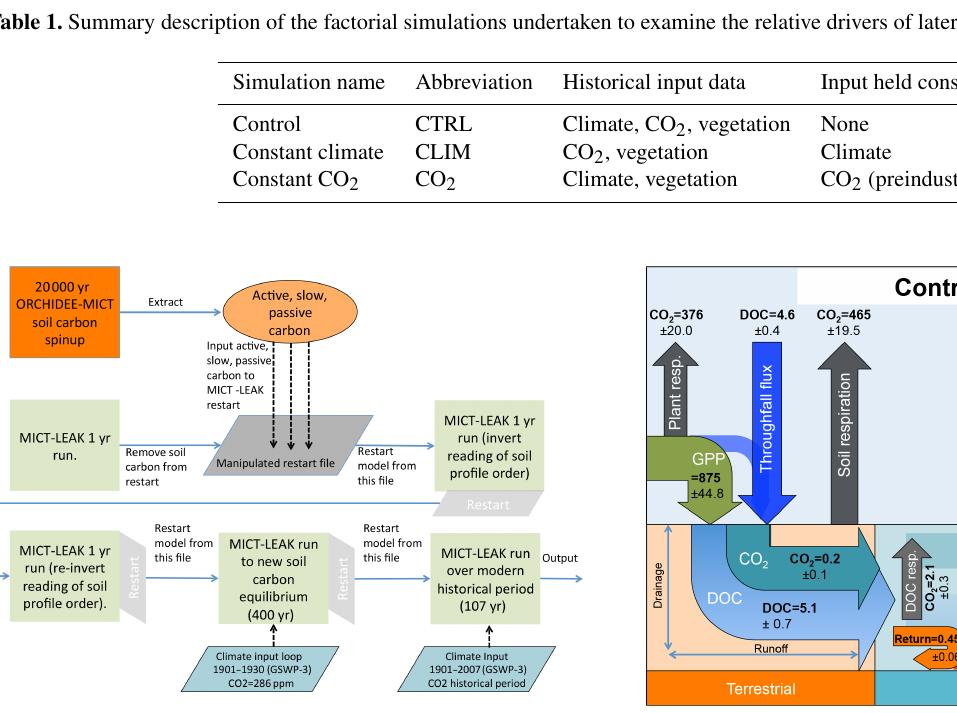
Figure 2. Schematic diagrams detailing the major yearly carbon flux outputs (TgCyr − 1 ) from the control simulation averaged over the period 1998–2007 as they are transformed and transported across the land–aquatic